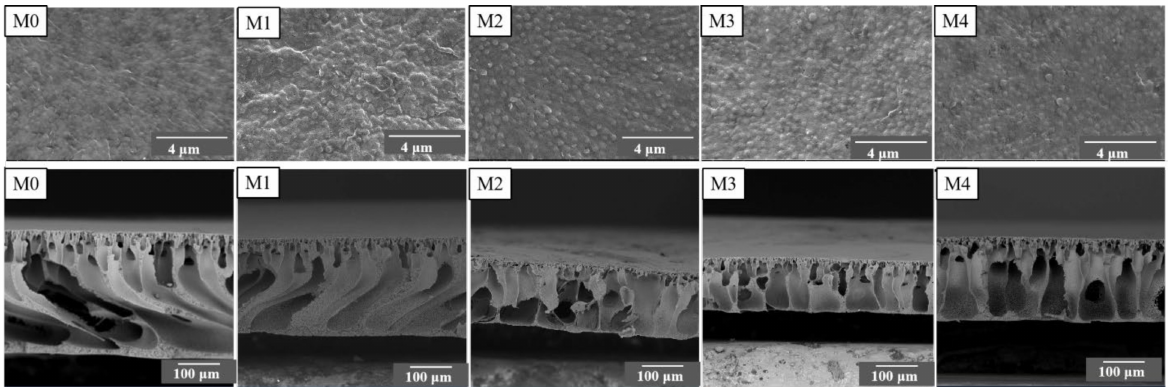
Figure 2. SEM images for the surface (upper row) and cross-section (low row) morphologies of the PVDF blend mem- branes M0 (weight ratio of PVDF: Additive = 10:0), M1 (weight ratio of PVDF: P(St x - co -MAA y )- g -fPEG z (x:y = 4:1) = 9:1), M2 (weight ratio of PVDF: P(St x - co -MAA y )- g -fPEG z (x:y = 4:1) = 7:3), M3 (weight ratio of PVDF: P(St x - co -MAA y )- g -fPEG z (x:y = 4:1) = 9:1), M4 (weight ratio of PVDF: P(St x - co -MAA y )- g -fPEG z (x:y = 4:1) =